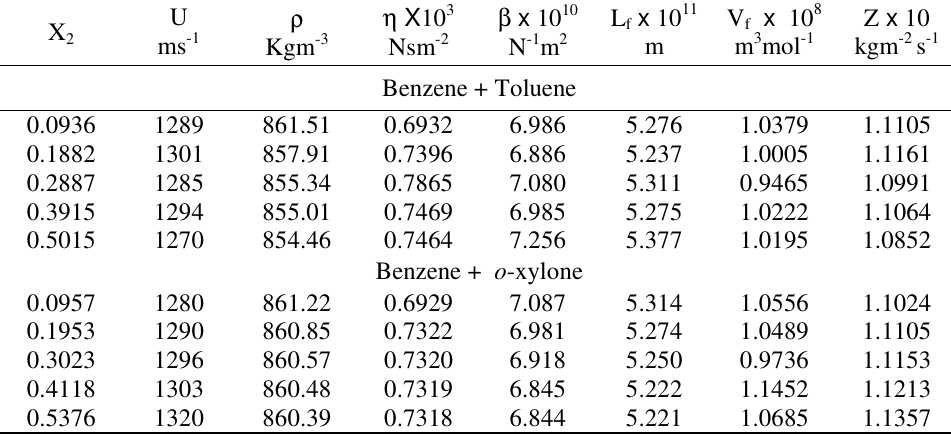
Table 1. Measured (Ultrasonic velocity (U), density ( ρ ) and viscosity ( η ) and calculated (adiabatic compressibility ( β ), free length (L (Z) parameters for benzene + toluene, o -xylone at 303